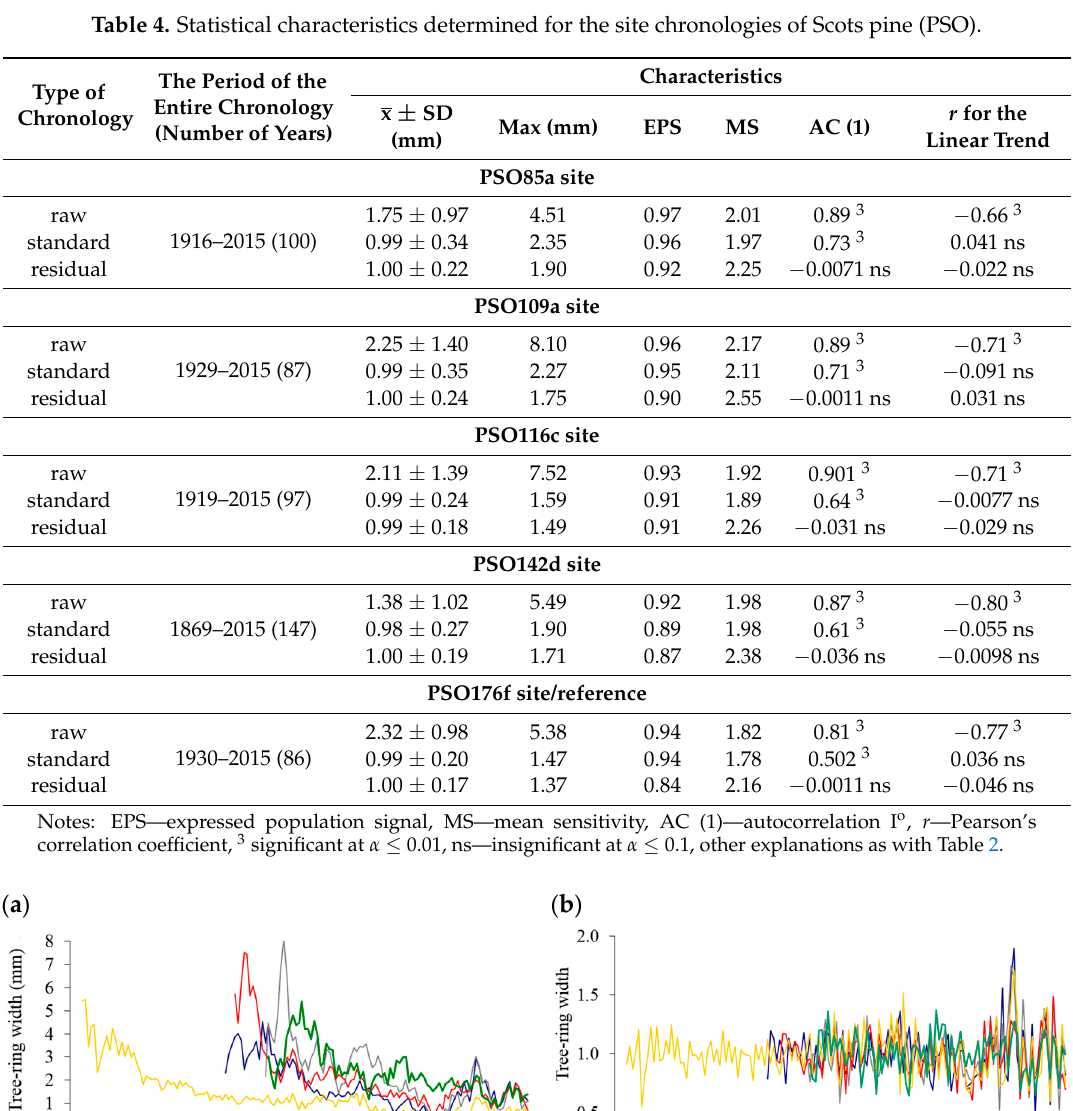
Table 4. Statistical characteristics determined for the site chronologies of Scots pine (PSO).